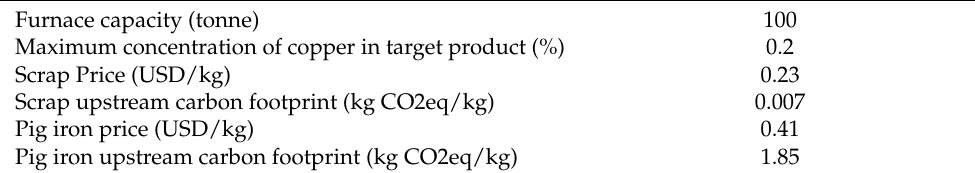
Table A1. Input data used for calculations shown in Table